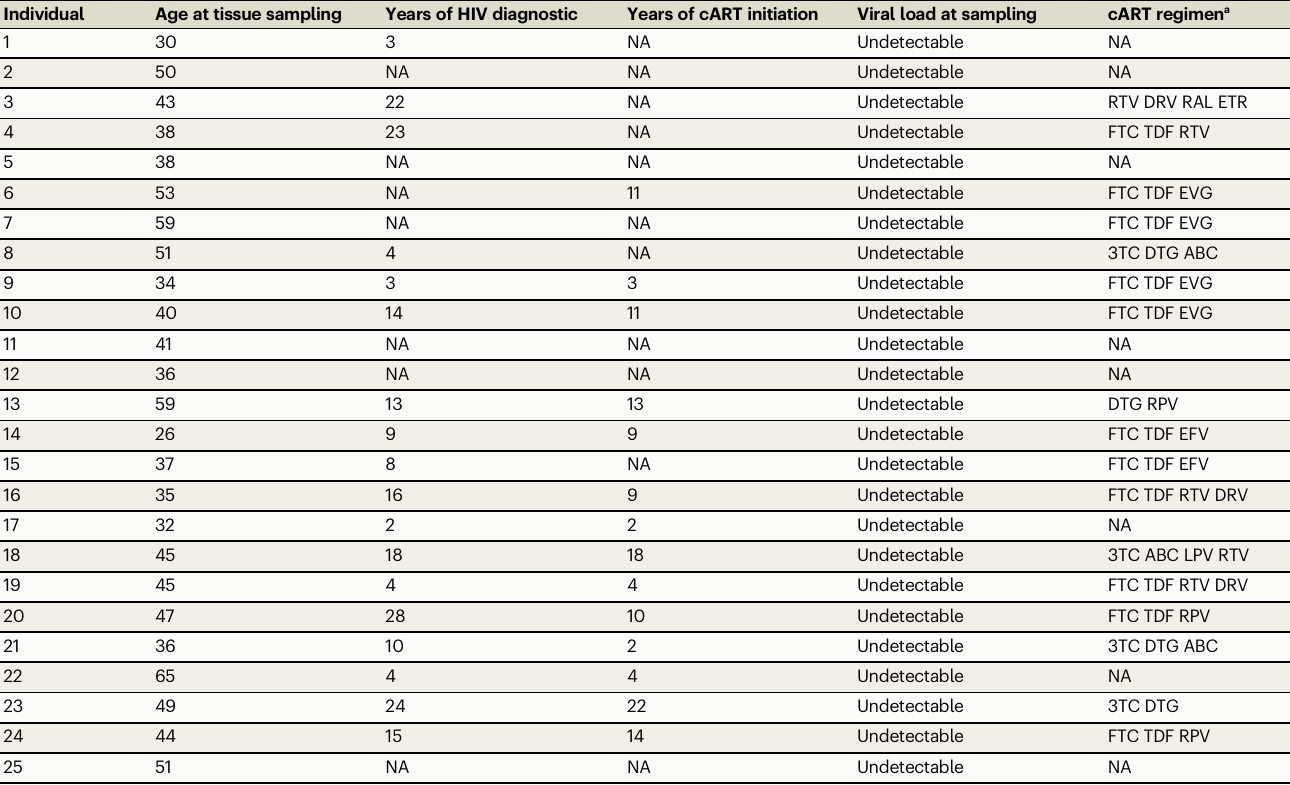
Table 1 | Clinical information of HIV-infected cART-suppressed individuals enrolled in this study